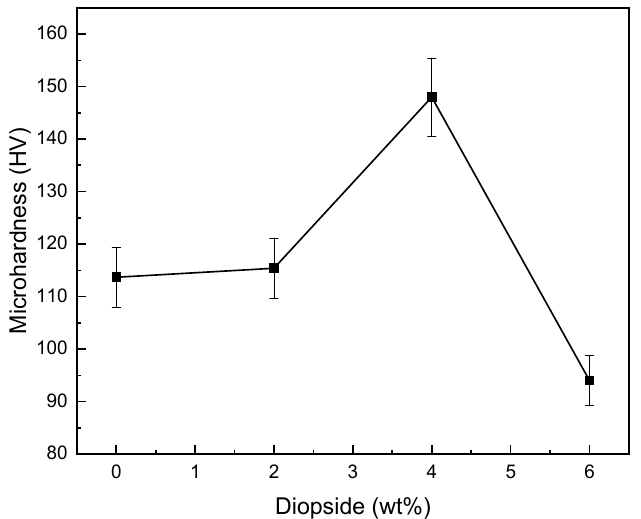
Figure 8. Microhardness of glass ionomer and glass ionomer diopside nanocomposites with different weight percentages.